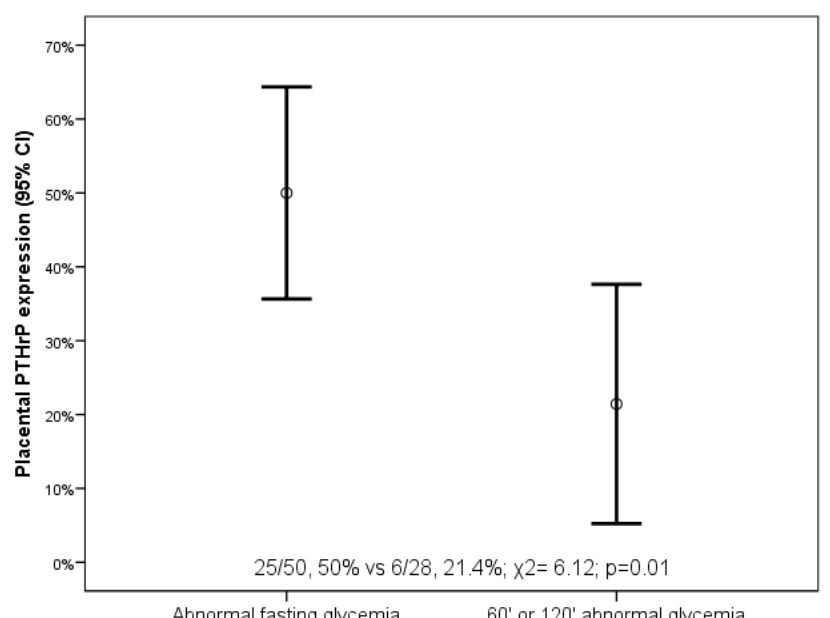
Figure 3. PTH-rP expression in extravillous cytotrophoblast in women with gestational diabetes according to type of abnormal glycemia at oral glucose tolerance test.